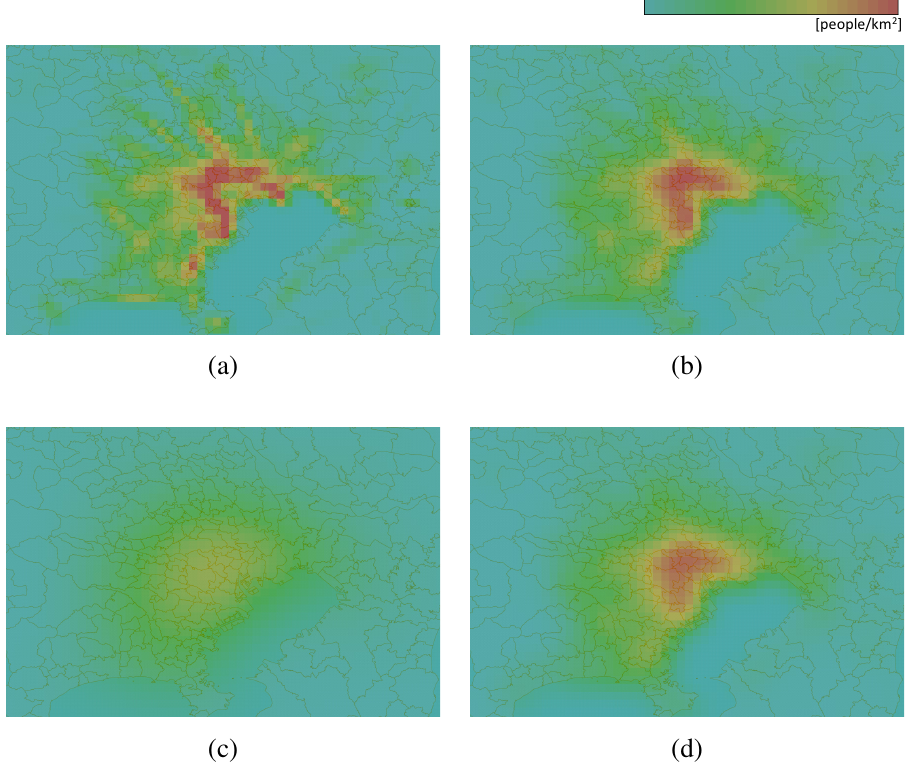
Figure 7. Visualized distributions (7:00 a.m.). ( a ) Proposed algorithm; ( b ) Gaussian-kernel estimator; ( c ) quadratic-kernel estimator ( h = 3 . 0 ); ( d ) quadratic-kernel estimator ( h = 1 . 0